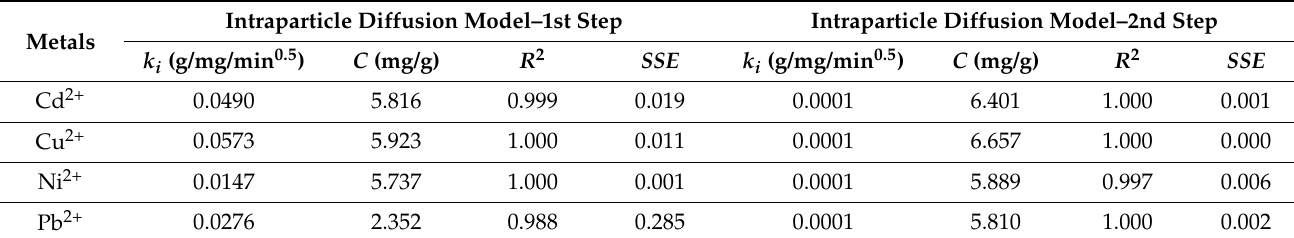
Intraparticle Diffusion Model–1st Metals